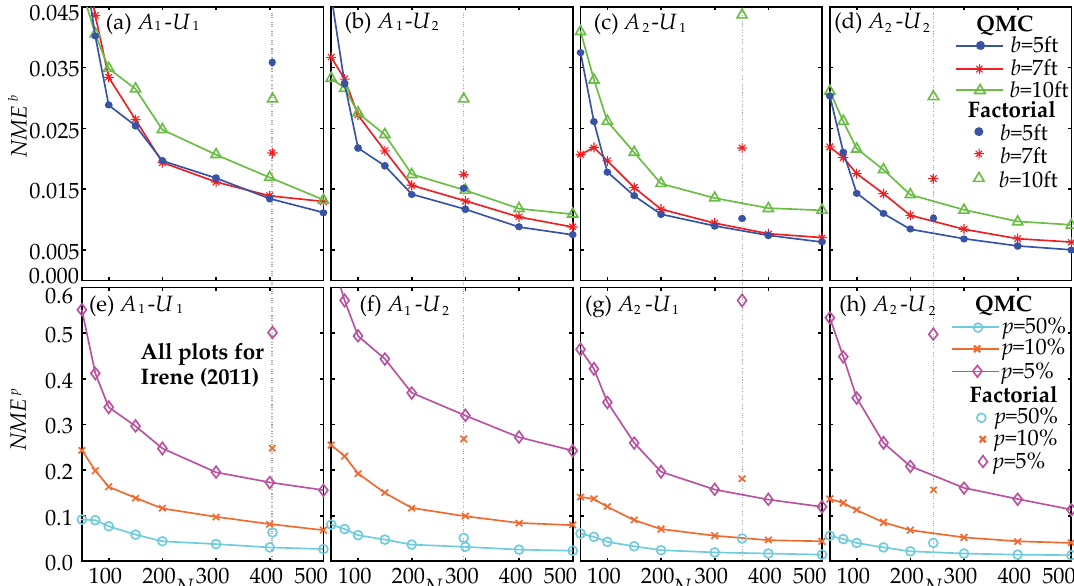
Figure 5. Normalized accuracy metrics b NME (top row) and p NME (bottom row) as functions of the number of samples r N used for hurricane Katrina (2005) for two different advisories and two uncertainty scenarios. First two columns correspond to advisory A 1 and uncertainty scenarios U 1 (first column) and U 2 (second column), while the two last columns correspond to advisory A 2 and uncertainty scenarios U 1 (third column) and U 2 (fourth column), respectively. Results for both the QMC (curves as function of samples) and the factorial sampling (for a specific sample size) are shown. A gray, dashed, vertical line is added to distinguish more easily the factorial sampling.